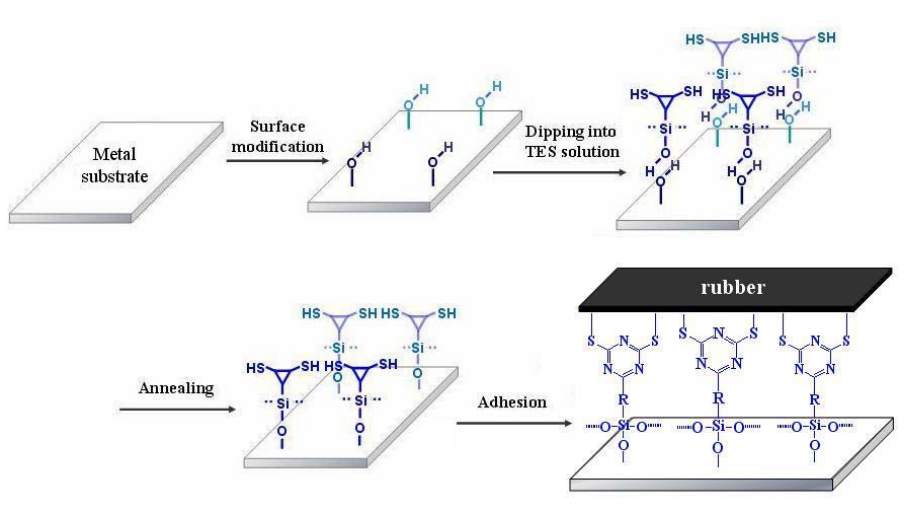
Figure 8. Model illustration of surface modification of the substrate by different